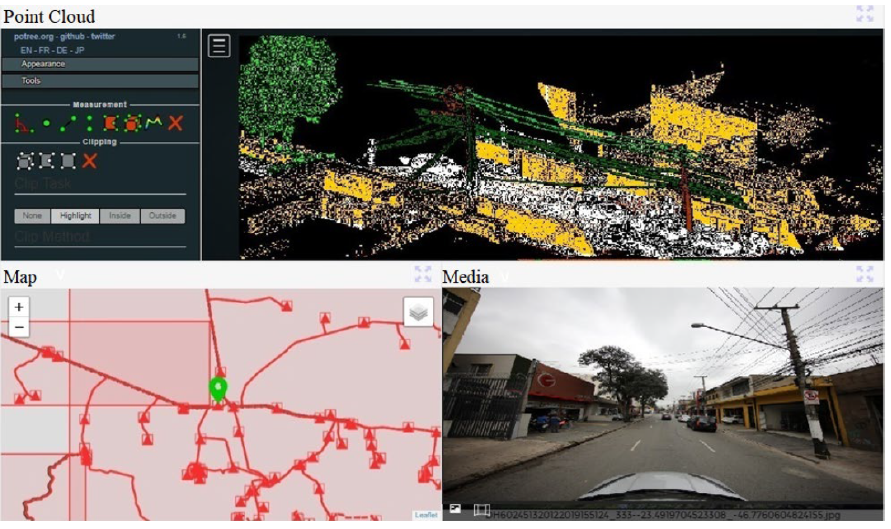
Figure 12. Example of MMS system